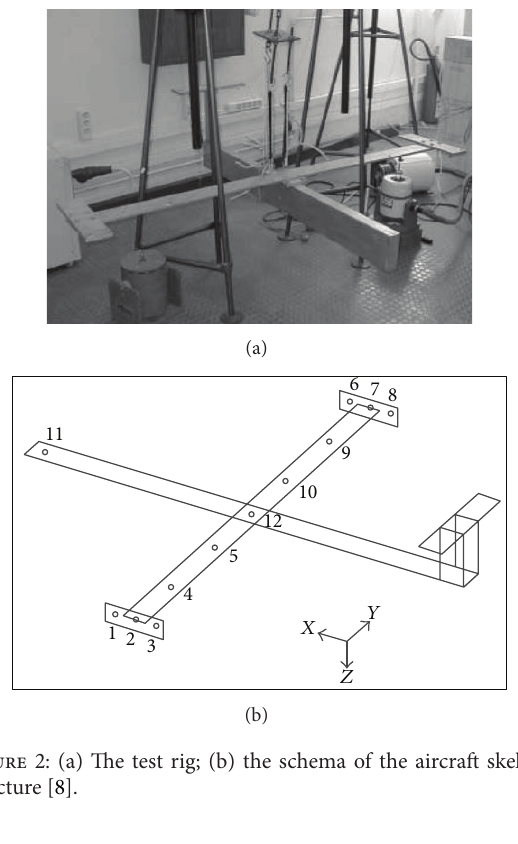
Figure 2: (a) The test rig; (b) the schema of the aircraft skeleton structure [8].